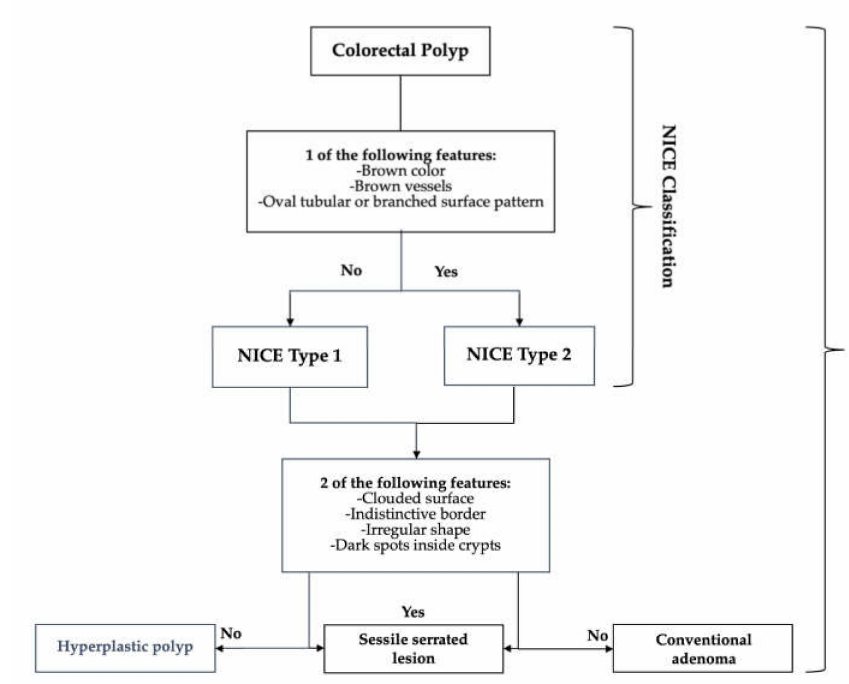
Figure 2. NBI International Colorectal Endoscopic (NICE) and (WASP) classifications for distinguish- ing between hyperplastic and adenomatous